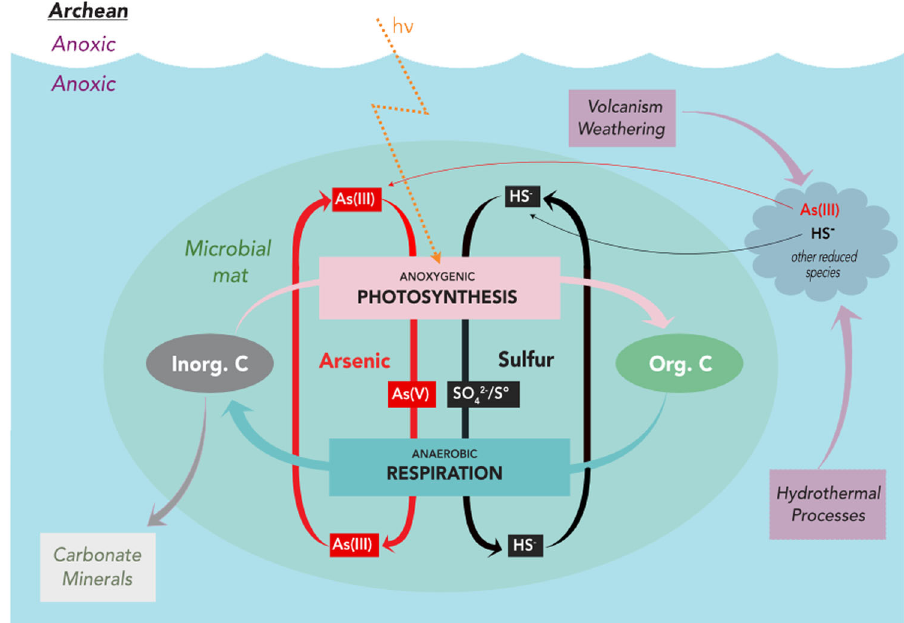
Fig. 4 Model of Archean arsenic and sulfur cycling. Conceptual model of arsenic and sulfur cycling in the Archean based on observations of contemporary mats in the La Brava channel. The aqueous environment of the La Brava channel mats is permanently anoxic, replicating Archean conditions more closely than other modern mineral-forming mat systems. These mats support vigorous arsenic and sulfur cycling coupled to carbon fi xation (anoxygenic photosynthesis) and reoxidation of organic C (anaerobic respiration). The La Brava channel is replete with reduced species (including As(III) and reduced sulfur) and mimics the vast hydrothermal delivery in the Archean. These reduced species are potential electron donors for anoxygenic photosynthesis, which we demonstrate for the La Brava mats and propose for Archean microbial mats. Precipitation of carbonate minerals may be enhanced by the effect of microbial metabolisms (especially arsenate reduction) on alkalinity and saturation indices (which were considerably higher in the